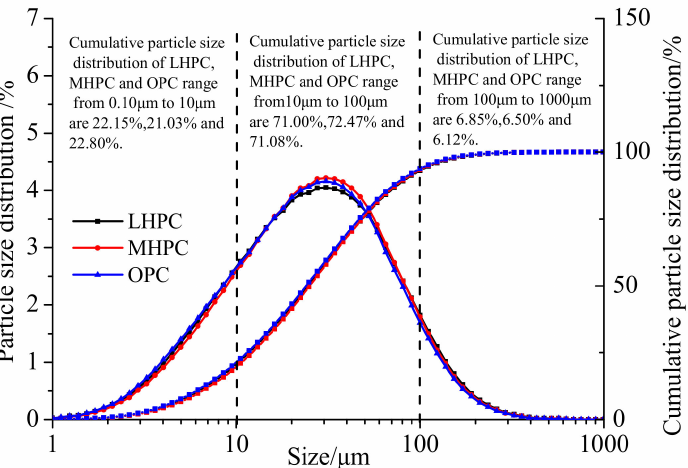
Figure 1. The particle size distribution of low-heat Portland cement (LHPC), medium-heat Portland cement (MHPC) and ordinary Portland cement